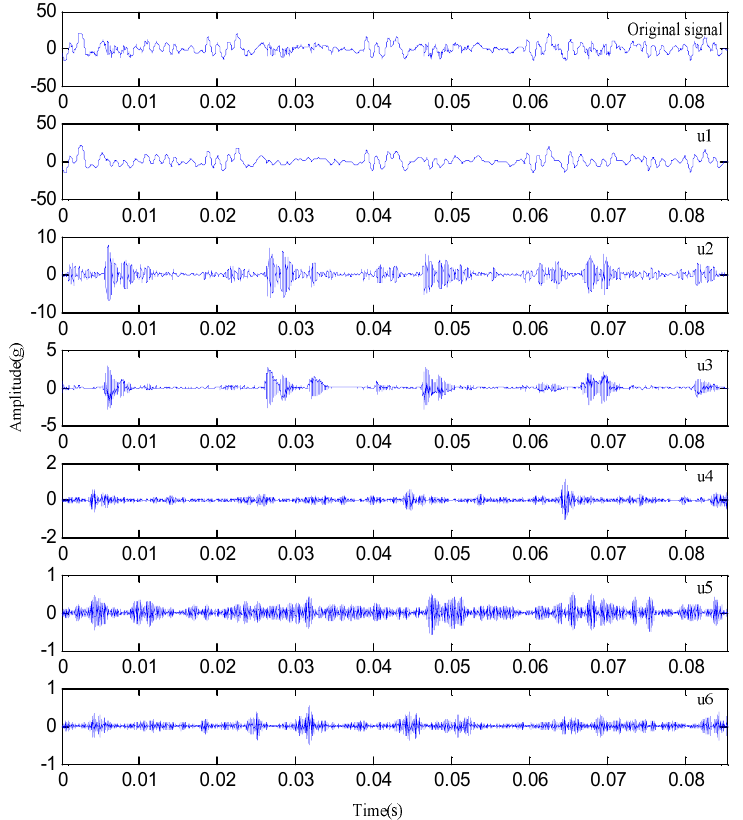
Figure 11. Test signal and decomposition results by FE-guided VMD.